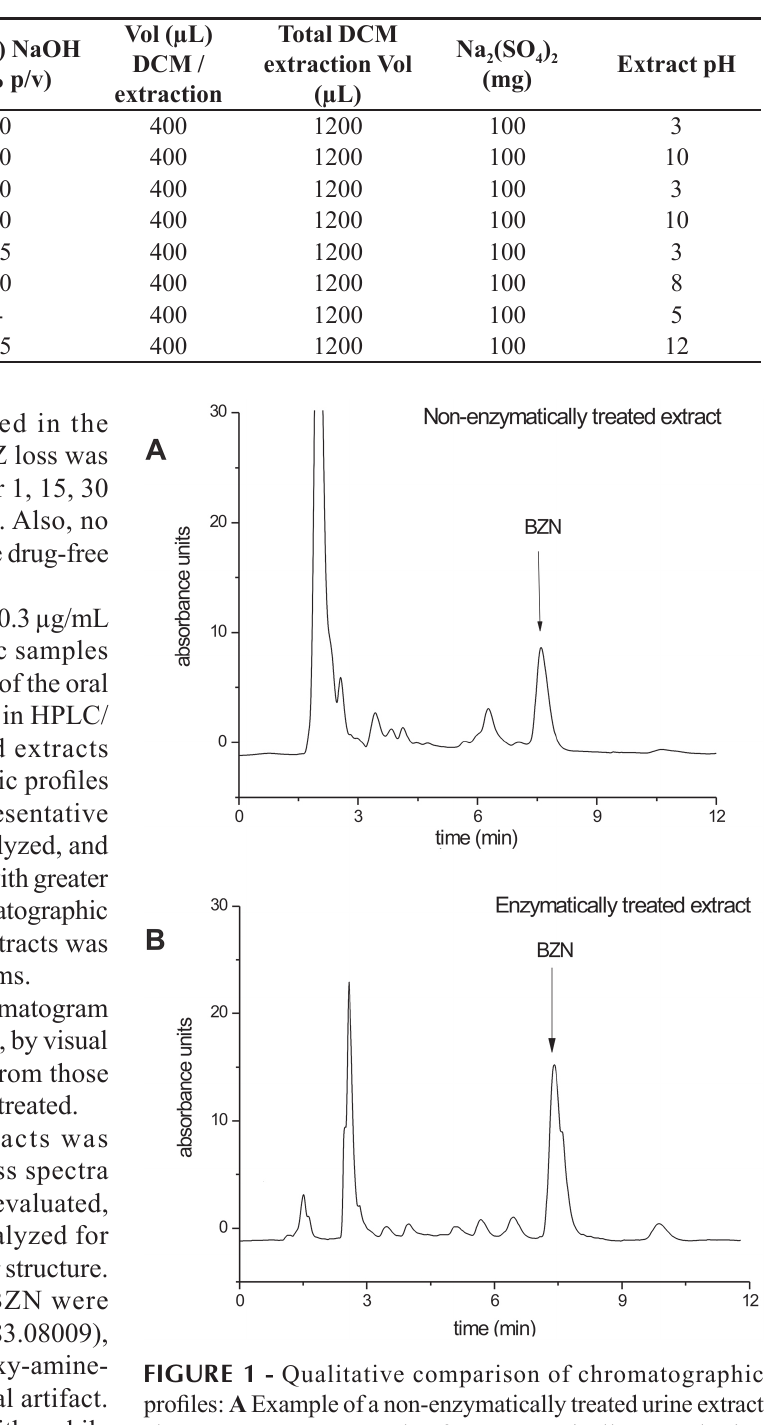
TABLE II - Extraction procedure from urine samples after enzymatic treatment